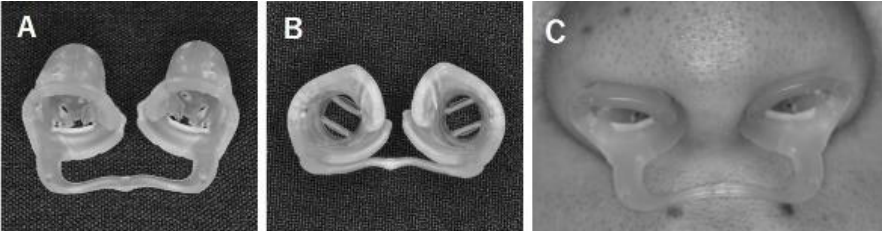
Figure 1. A novel nasal dilator; the nasal breathing stent (NBS). ( A ) Front view; ( B ) upper view; ( C ) NBS set.